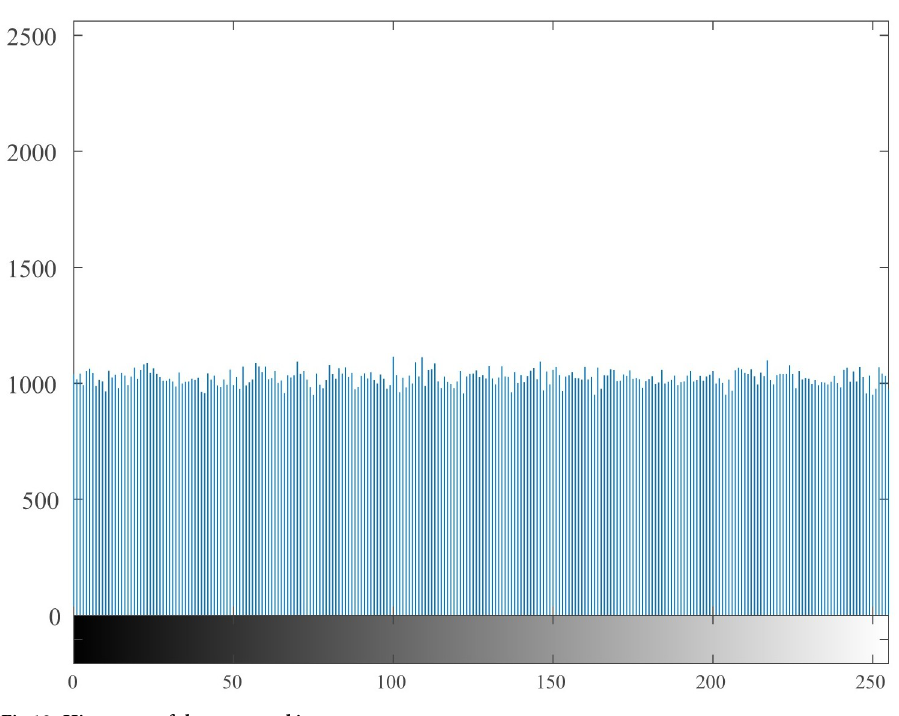
Fig 10. Histogram of the encrypted image.